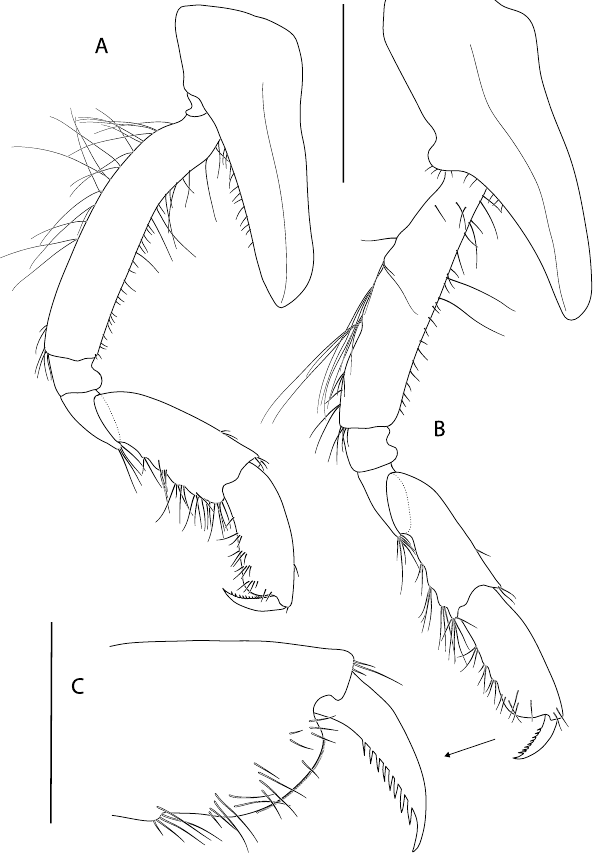
Figure 11. Epimeria frankei sp. nov., holotype, adult female, northern North Sea, NHMUK 2015.3264: ( A ) gnathopod 1, ( B ) gnathopod 2, ( C ) distal articles of gnathopod 2; scales: (A,B) 1 mm; (C) 0.3